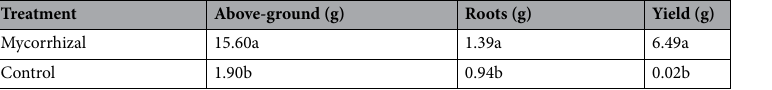
Table 6. Effects of AMF inoculation on dry matter accumulation and yield of peanut. Within each column, mean values not followed by the same letter are significantly different by LSD ( p <